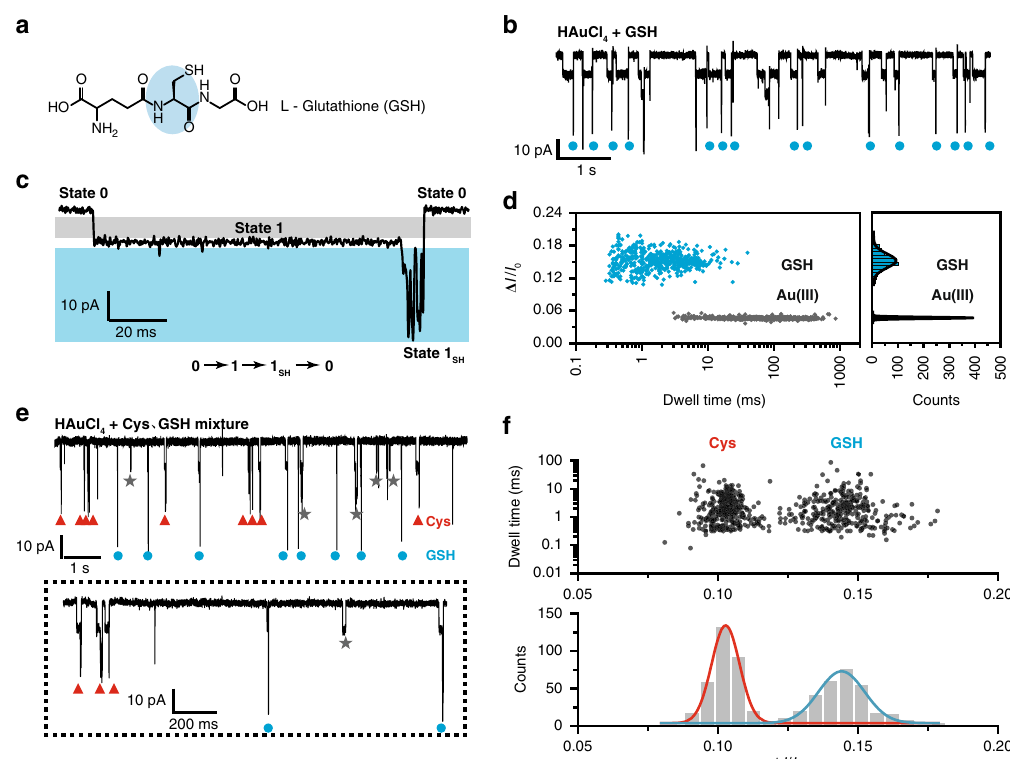
Fig. 5 Stochastic sensing of L-Glutathione by Au(III) embedded MspA-M. a The chemical structure of L-Glutathione (GSH). GSH is a tripeptide containing a cysteine residue (blue labeled portion). b Reversible and sequential binding of GSH with [AuCl 4 ] − embedded MspA-M. The demonstrated trace was recorded with a + 100 mV applied voltage when 4 μ M HAuCl 4 in cis and 40 μ M GSH in trans were present simultaneously. Resistive pulse signals in the trace represent GSH binding with the pore. Blue dots mark the events concerning GSH. Other unlabeled events are background signals as described in Supplementary Fig. 14. c A representative GSH blockage event. Characteristic jitter signals similar to that of Cys or Hcy can be recognized as state 1 SH . However, the mean blockage amplitude of state 1 SH for GSH is systematically deeper than that of Cys or Hcy. Gray and blue marked regions represent the the area that the transition of state 0 – 1 or state 1 – 1 SH distributes respectively. d The scatter plot of Δ I / I 0 vs the dwell time with the corresponding amplitude histogram from events of [AuCl 4 ] − or GSH binding. The de fi nition of Δ I and I 0 is the same as that described in Fig. 3f. The statistical data in d were from a continuous 10 min recording as described in b . (Supplementary Tables 9 and 10). e Simultaneous discrimination of GSH and Cys with [AuCl 4 ] − embedded MspA-M. Cys and GSH were placed in trans with a concentration of 10 μ M and 30 μ M, respectively. Whereas, the concentration of HAuCl 4 in cis was kept at 4 μ M. In the dotted box, a zoomed-in view of GSH and Cys events were demonstrated. Red triangles mark the events of Cys and blue dots mark those of GSH. The grey star marks binding events from one or two [AuCl 4 ] − . f The scatter plot of the dwell time vs the Δ I / I 0 with the corresponding amplitude histogram from the simultaneous recording of Cys and GSH as a mixture with 10 μ M and 30 μ M in trans , respectively. The statistical data were derived from a continuous 10 min